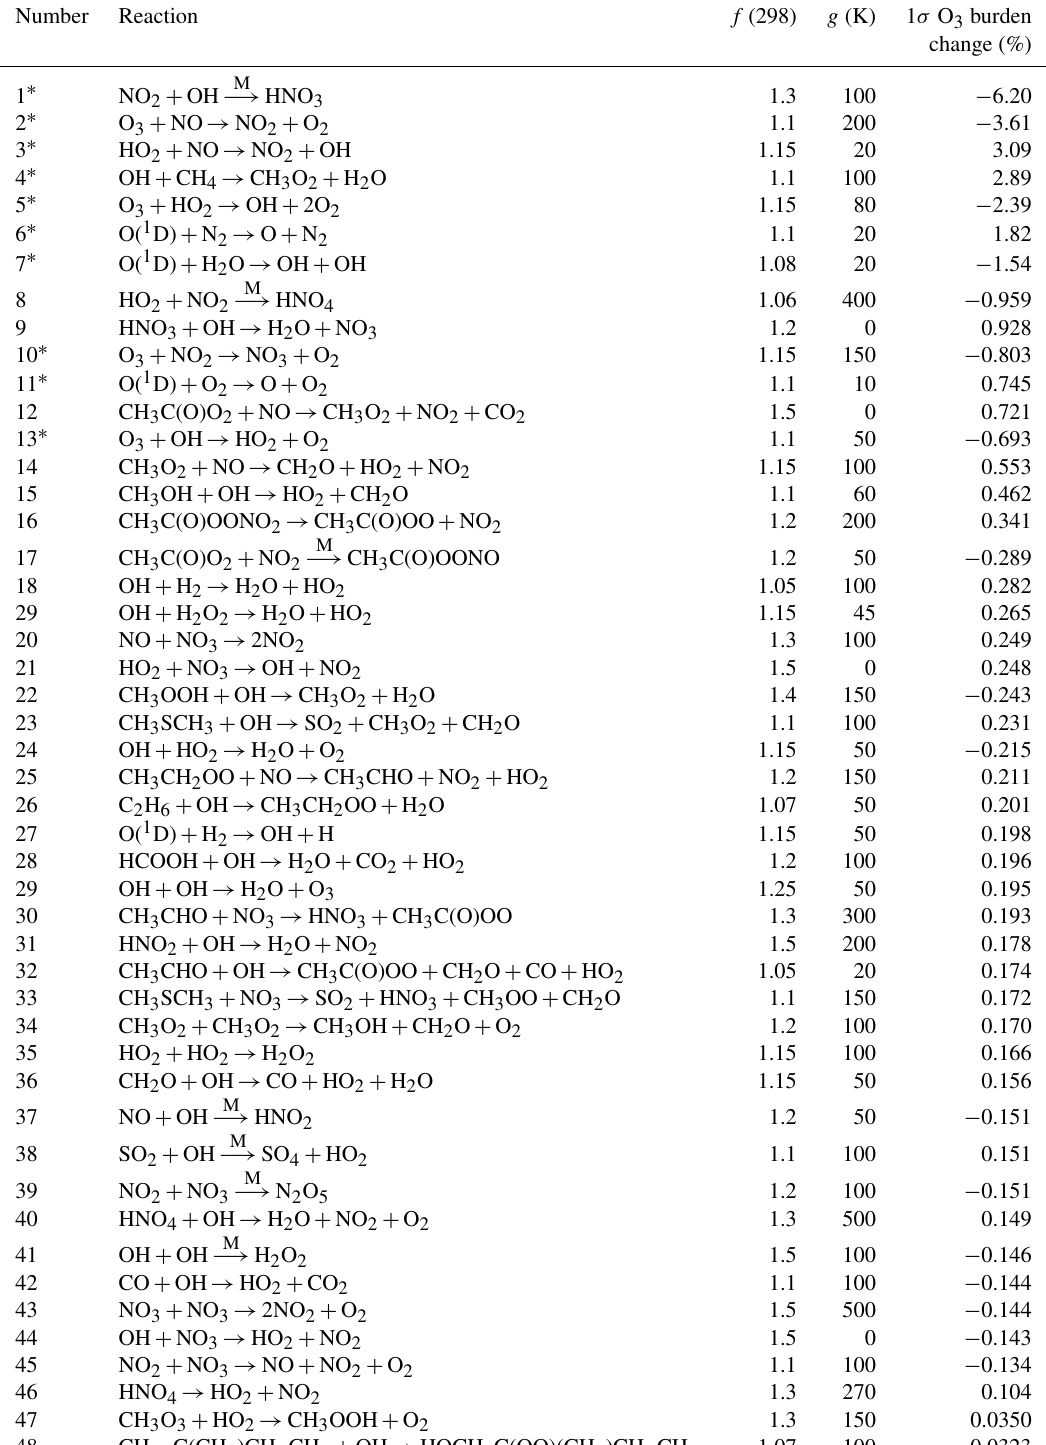
Table 1. Table of reactions studied. f (298) indicates the JPL or IUPAC panel uncertainty estimate at 298K and g gives the rate at which this uncertainty increases away from 298K (see previous section). Reactions with 0 for the temperature dependence indicate there is zero temperature dependency or not enough information to provide a temperature-varying uncertainty. The final column gives the fractional increase in the ozone burden by increasing the rate constant to its 1 σ value. Reactions with a ∗ are the 10 reactions used in the Monte Carlo